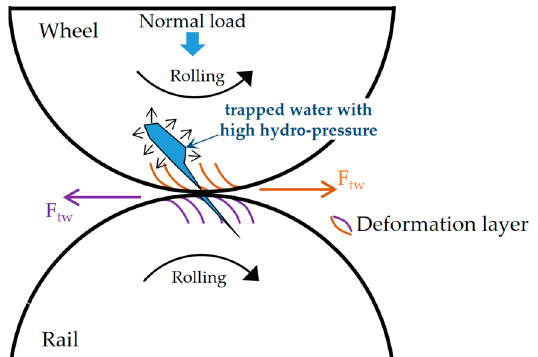
Figure 11. Schematic diagram of RCF crack propagation on wheel and rail rollers under the water condition adapted from [1].